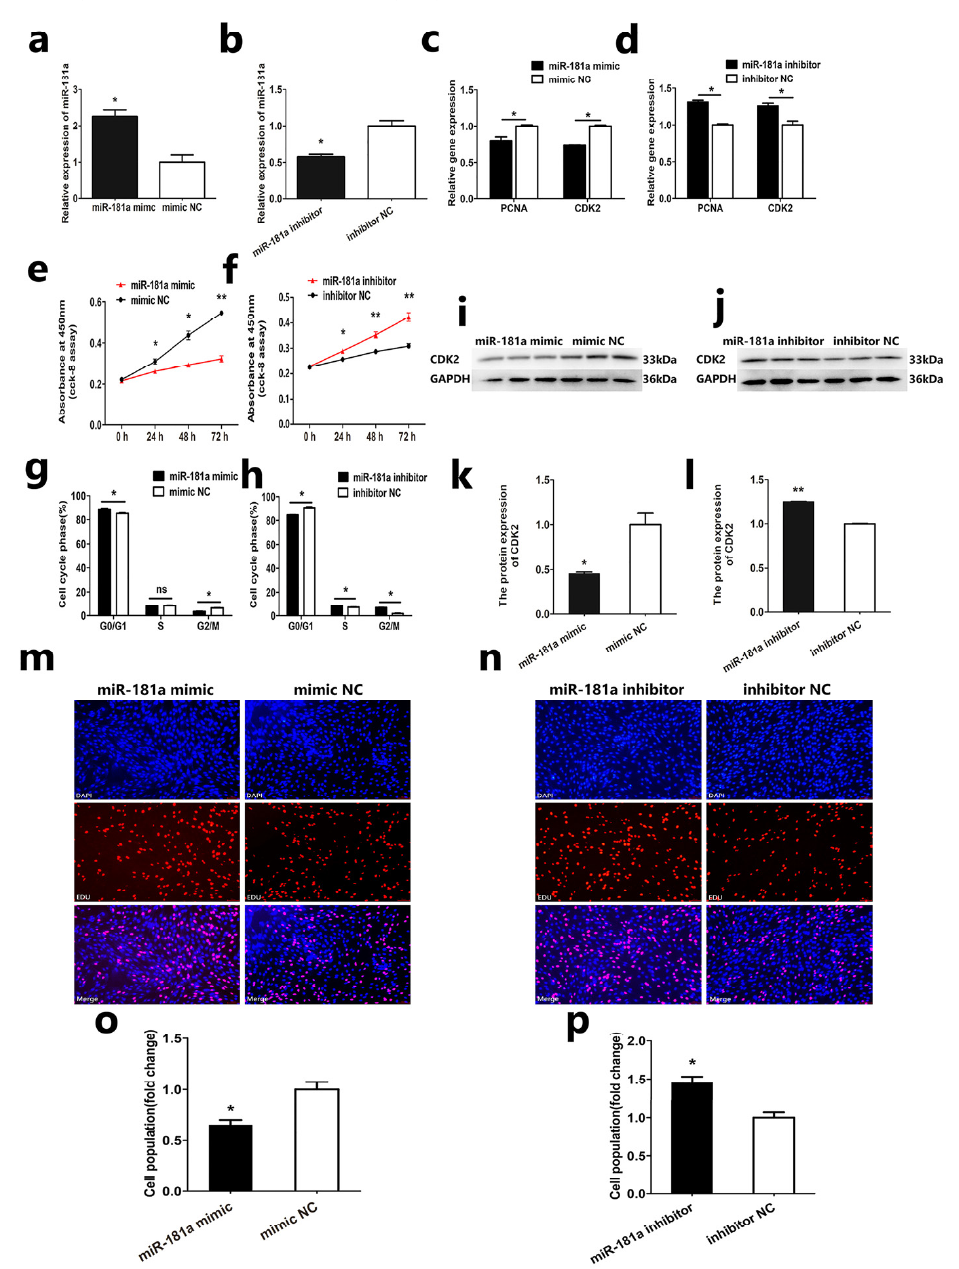
Figure 1. MiR-181a suppresses SMSCs’ proliferation in Hu sheep: ( a , b ) The relative expression of miR-181a; ( c , d ) The relative mRNA expression of PCNA and CDK2; ( e , f ) CCK-8 assay of SMSCs; ( g , h ) Cell-cycle analysis of SMSCs; ( i , j ) The relative protein expression of CDK2; ( k , l ) Statistical analysis of ( i , j ); ( m , n ) EdU assay of SMSCs. Fluorescence inverted microscope (Nikon, Tokyo, Japan) was used to obtain microscopic images. The magnification is 100 times; ( o , p ) Statistical analysis of EDU-stained cells in microscopic images of ( m , n ). In all graphs, all data are presented as means ± SEM (standard error of the mean) ( n = 3). Statistical significance was performed by unpaired Student’s t -test. (* p < 0.05; ** p < 0.01; ns p > 0.05) vs. NC (negative control).